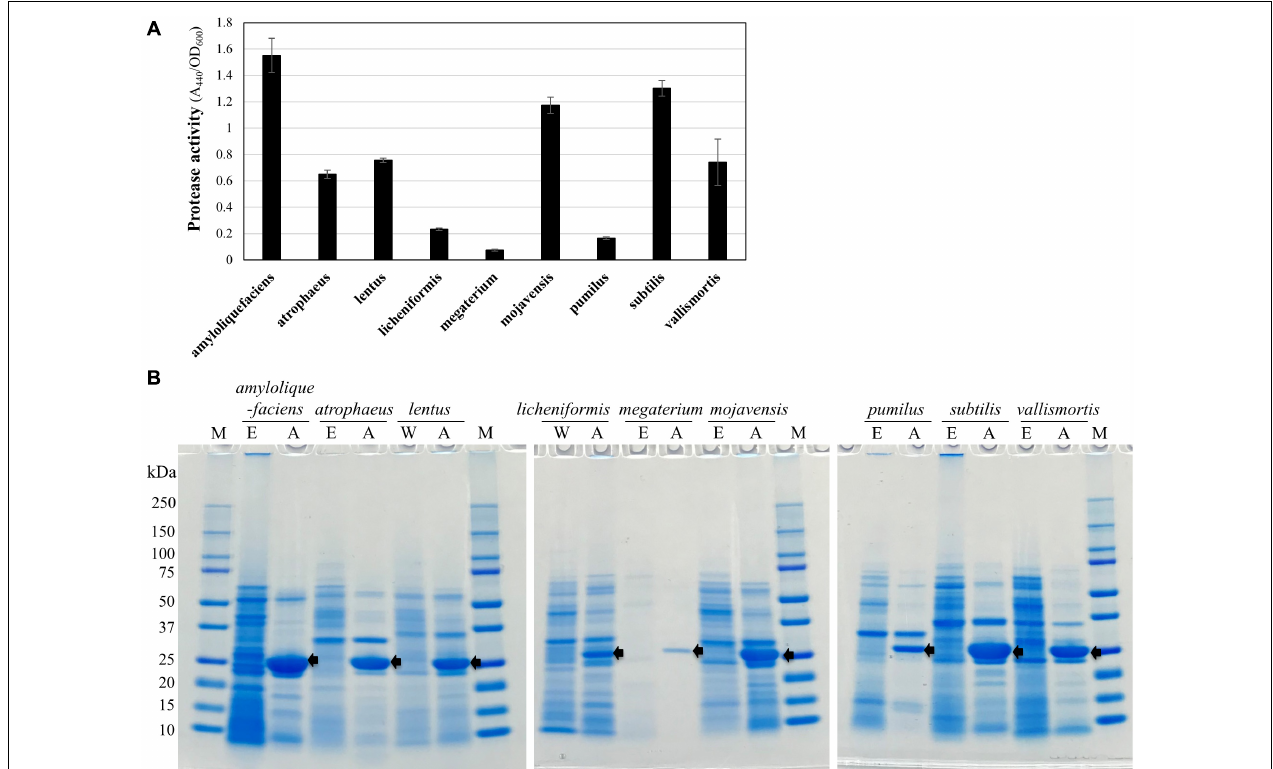
FIGURE 6 | Expression of a nattokinase gene ( aprN ) in edited QPS Bacillus strains. (A) Protease assay using azocasein as a substrate to determine protease activity of nattokinase-expressing QPS strains. The bars display the means of three independent experiments, with the error bars indicating standard deviations. (B) SDS-PAGE analysis of the total protein extracted from the 24-h culture supernatants of the QPS Bacillus strains. Protein molecular mass markers are indicated on the “M” lanes. The lanes marked with “W,” “E,” and “A” represent wild type, edited, and aprN -expressing strains, respectively. The size of AprN mature protease was 27.7 kDa, indicated by